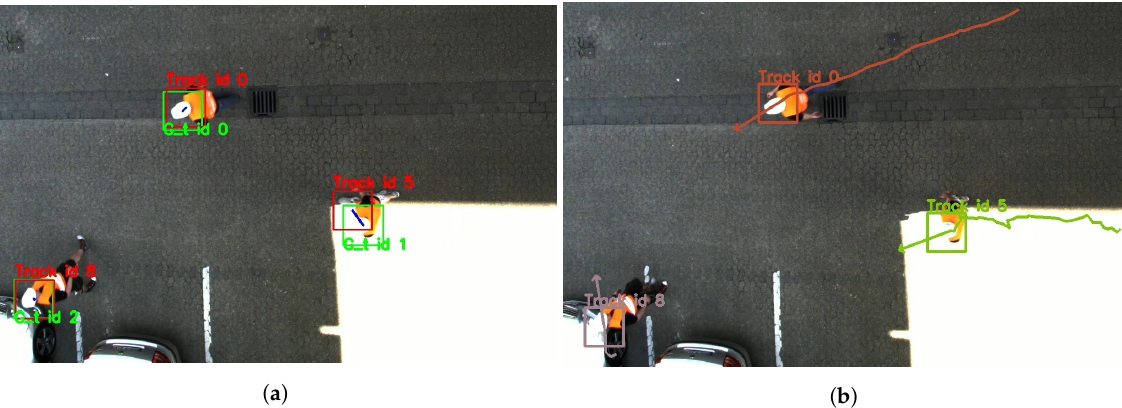
Figure 8. Example of the tracking performance of the classical approach on Scene 1. ( a ) Illustration of the AOS and CER measures. Ground truth labels (green) are compared to the actual tracks (red). Blue lines indicate the distance between the labels’ centers. ( b ) Tracking result. The worker’s current positions are given by randomly colored squares. Equally colored lines illustrate their previous walking paths. Arrows show their predicted walking